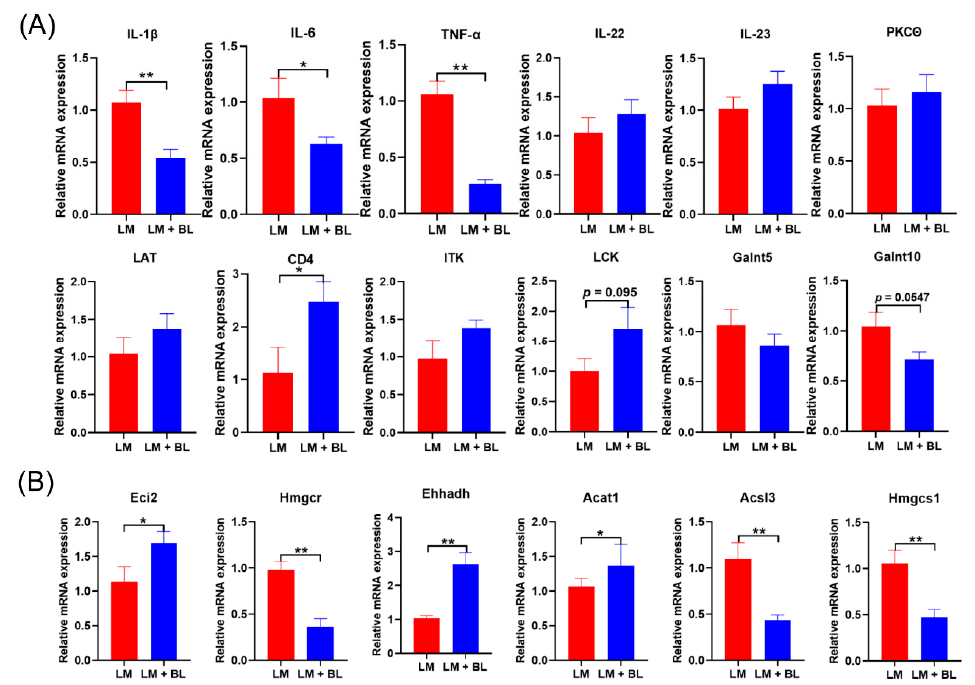
Figure 5. The mRNA expression of key DEGs: ( A ) Related cytokines IL-1 β , IL-6 , TNF- α , IL-22 , and IL-23 , and PKC θ , CD4 , LCK , LAT , ITK , Galnt5 , Galnt10 in colon, and ( B ) Eci2 , Hmgcr , Ehhadh , Acat1 , Acsl3, and Hmgcs1 in liver. Values are means with their standard error means represented by vertical bars ( n = 10). * means p < 0.05, ** means p < 0.01.